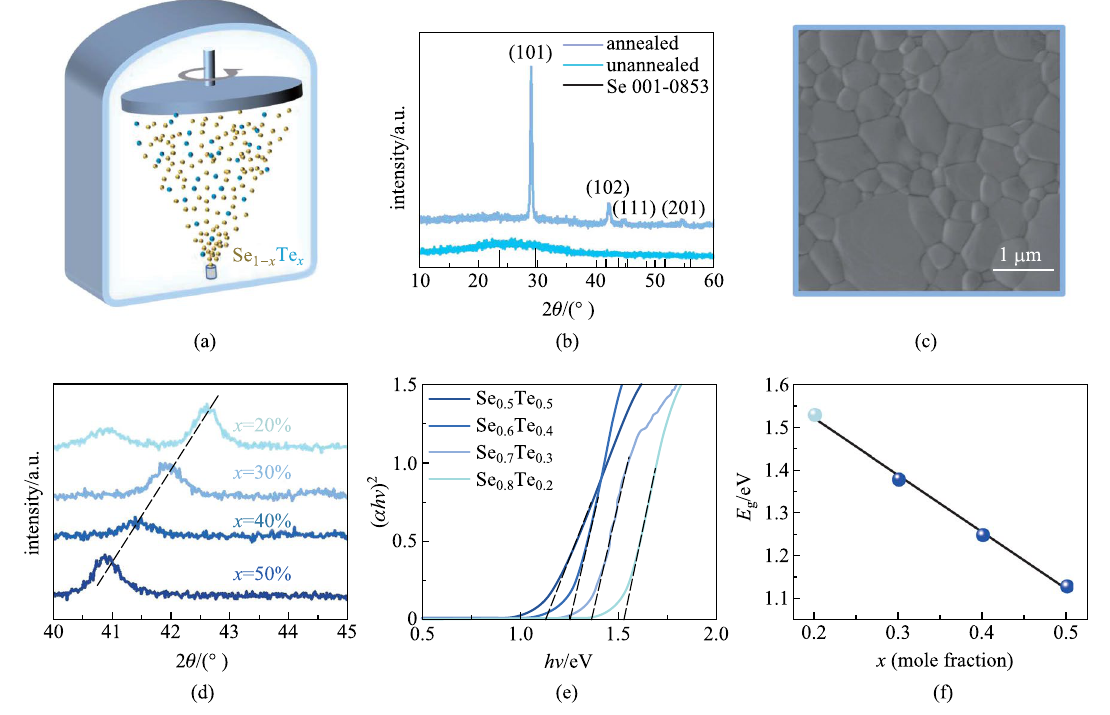
Fig. 1 a Schematic diagram of thermal evaporation. b XRD of Se